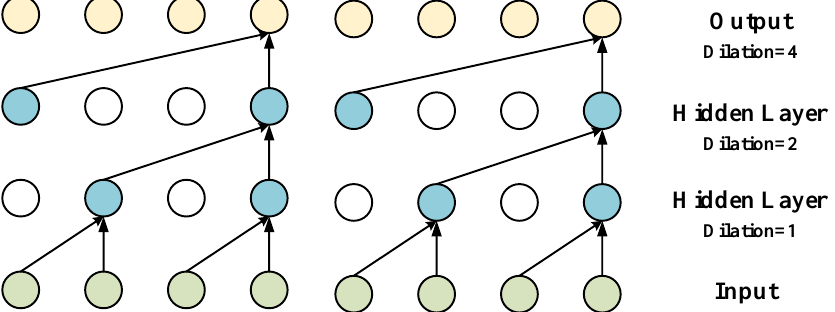
Figure 9. The process of dilated convolution. Dilated convolution applies the filter over a region larger than itself by skipping a certain number of inputs, which allows the network to have a large receptive field.